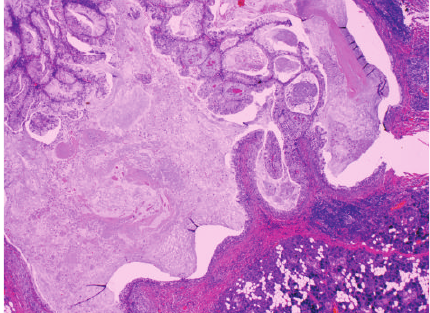
Figure 4: Low magnification photomicrograph showing a focus of the tumor infiltrating outside the lymph node and into the parotid parenchyma (20x;